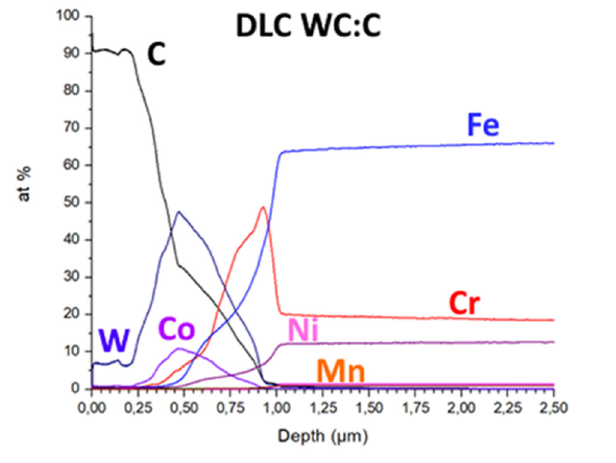
Figure 4. ( a ) Glow discharge optical emission spectrometry (GD-OES) concentration profile of DLC WC:C coating and ( b ) calotest to determine the coating thickness.